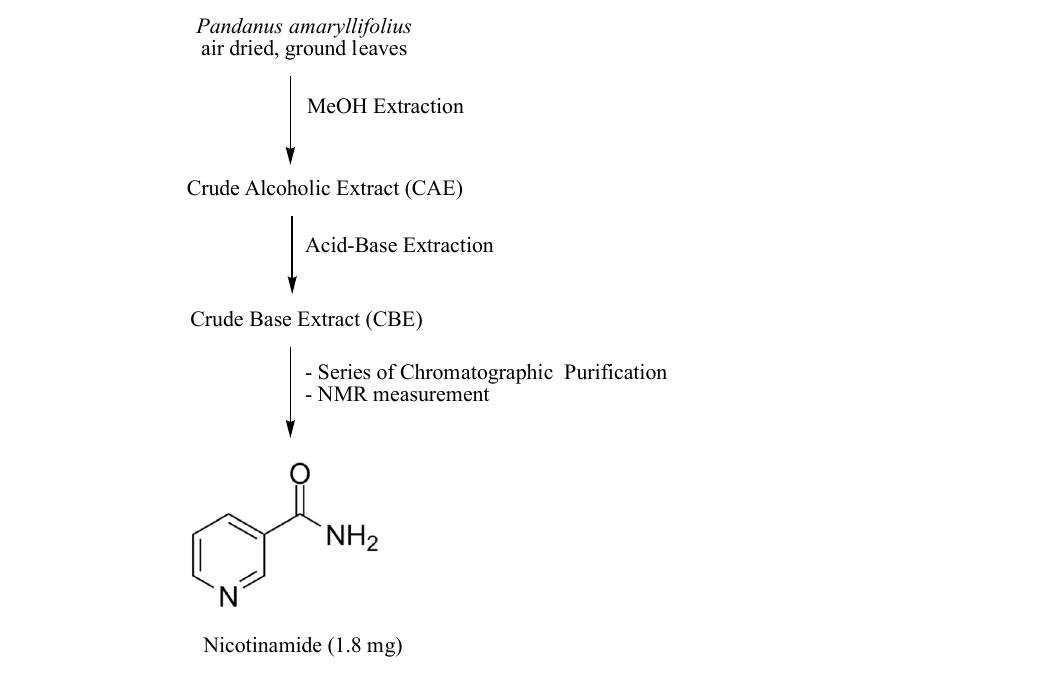
Figure 1. Schematic diagram on the isolation and identification of Nicotinamide.